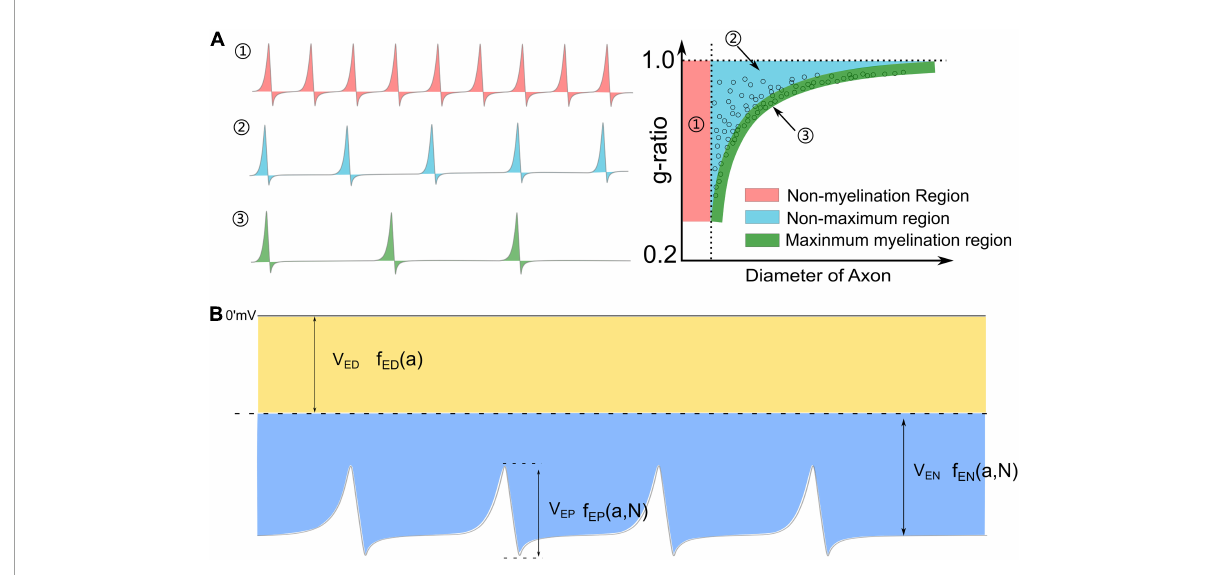
FIGURE9 (A) The relationship between the frequency of action potential and the thickness of myelin: (1) An axon with a very high frequency of action potentials tends to be unmyelinated; (2) An axon with a medium frequency of action potentials cannot have maximum myelin thickness; (3) An axon with a very low frequency of action potentials tends to have maximum myelin thickness, forming the lower edge of the g-ratio data. (B) A complete perspective of Hypothesis-E: the total voltage consists of three major components: V ED ,V EN , and V EP .